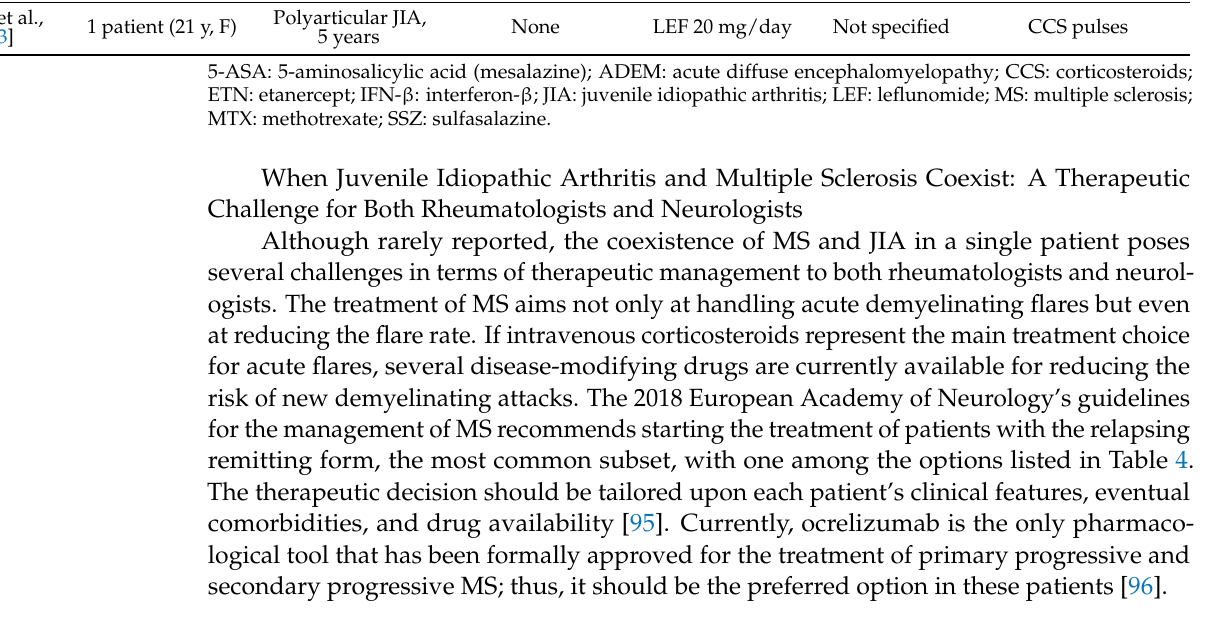
Table 4. Mechanisms of action of first line drugs for multiple